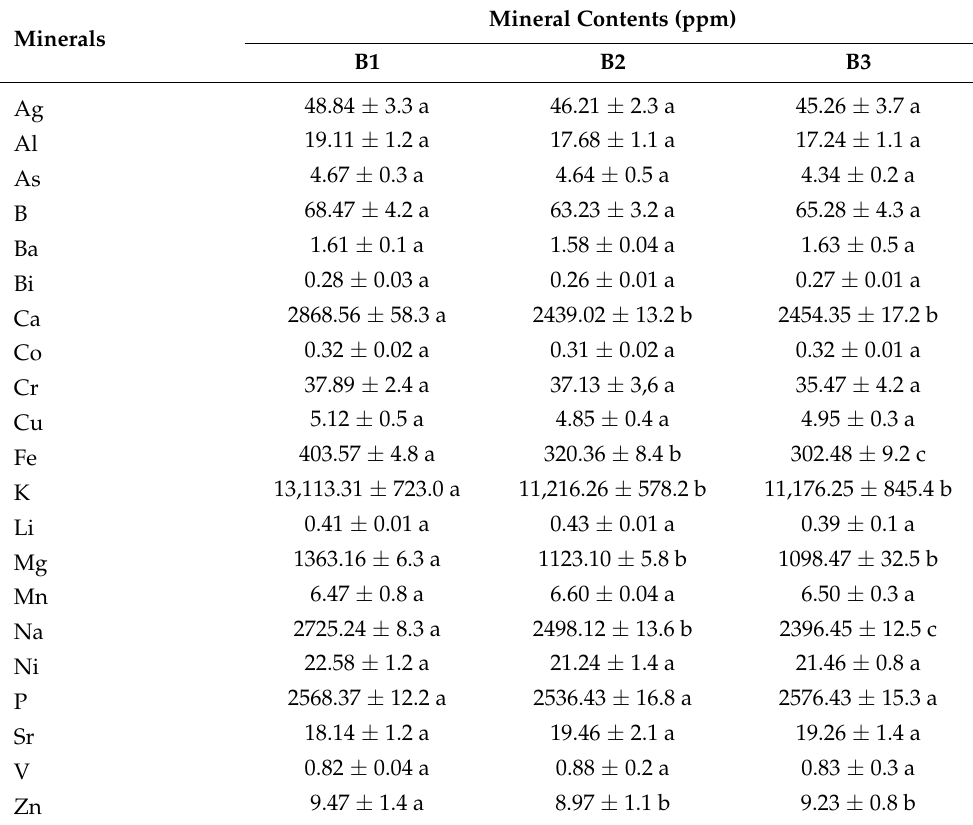
Table 4. Mineral contents detected in berberis